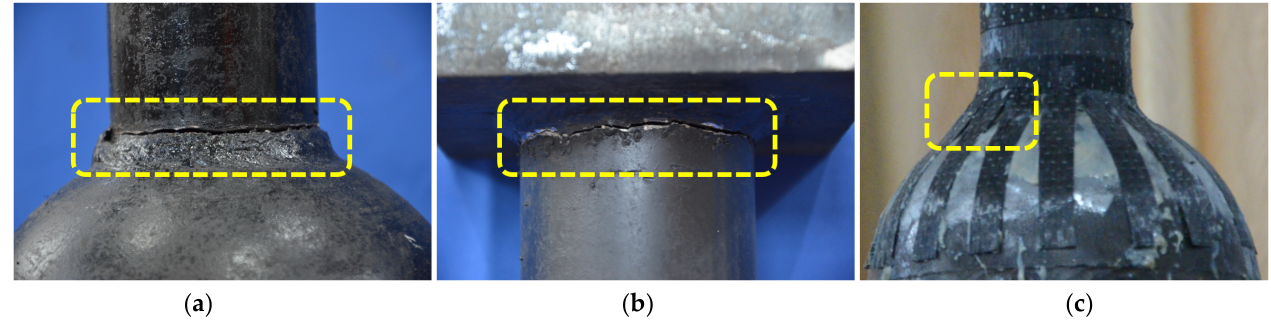
Figure 11. Typical failure mode of QP-76. ( a ) Failure mode 1 ( b ) Failure mode 2 ( c ) Failure mode 3.